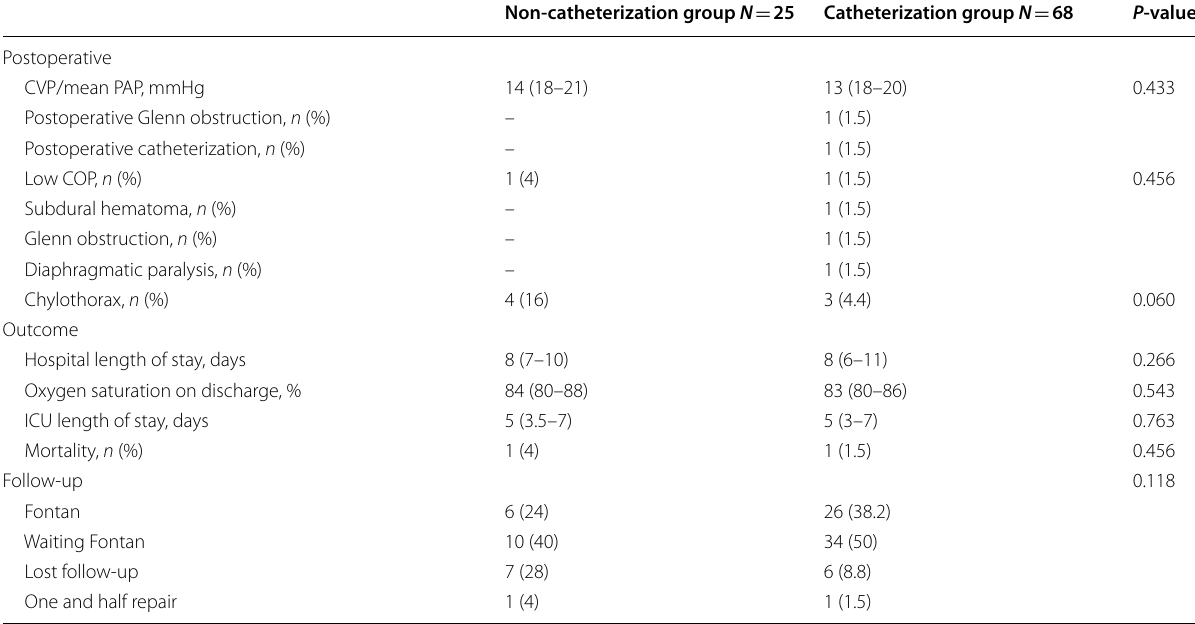
Table 3 Outcome of patients’